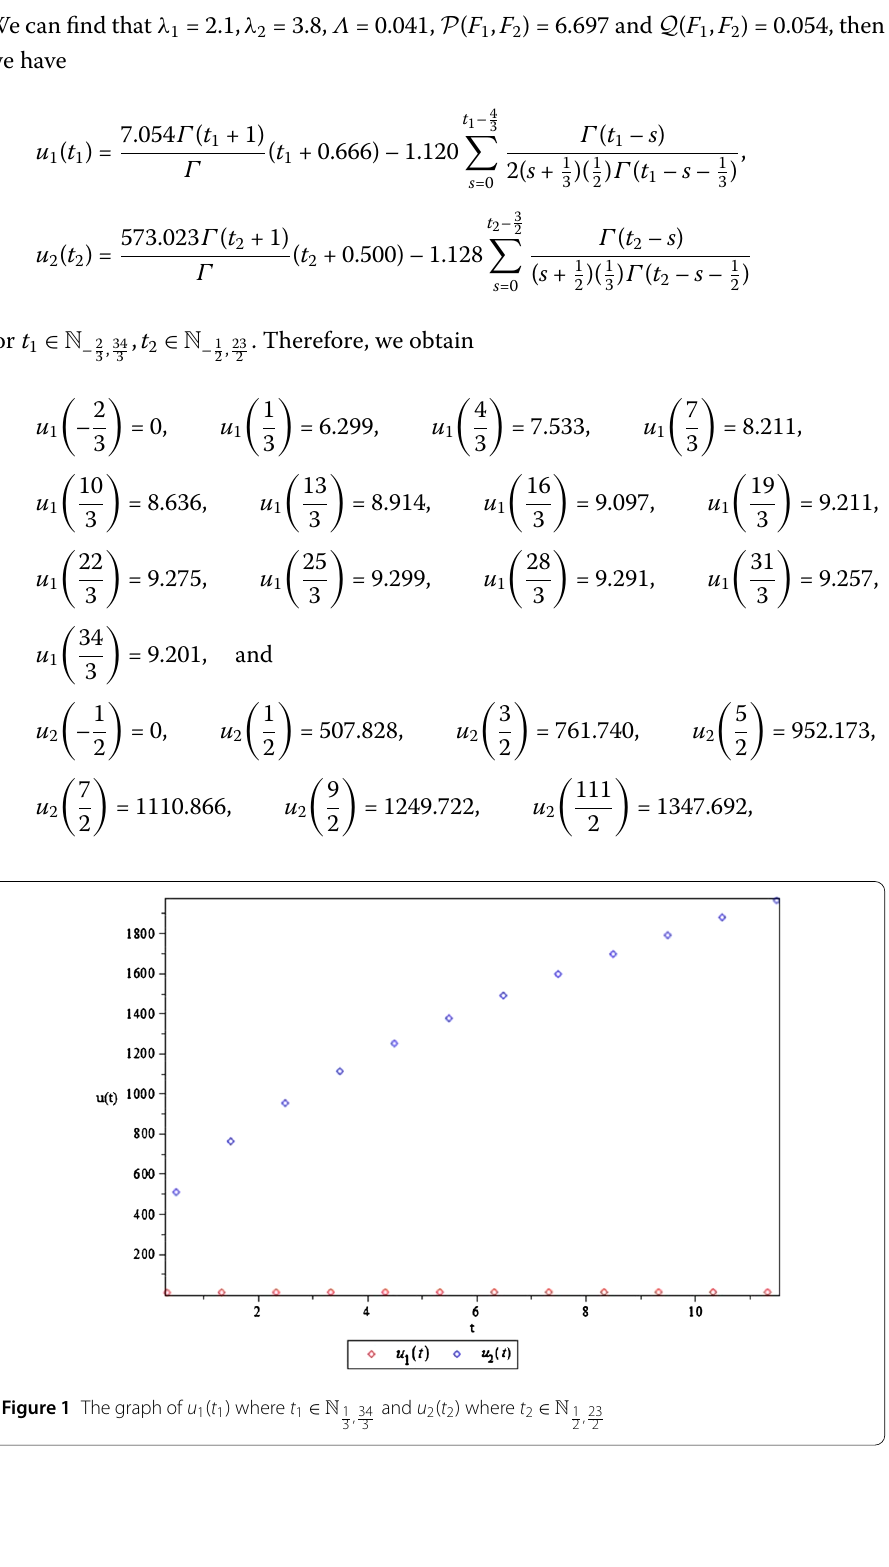
and u 2 ( t 2 ) where t 2 ∈ N 1 2,23 3